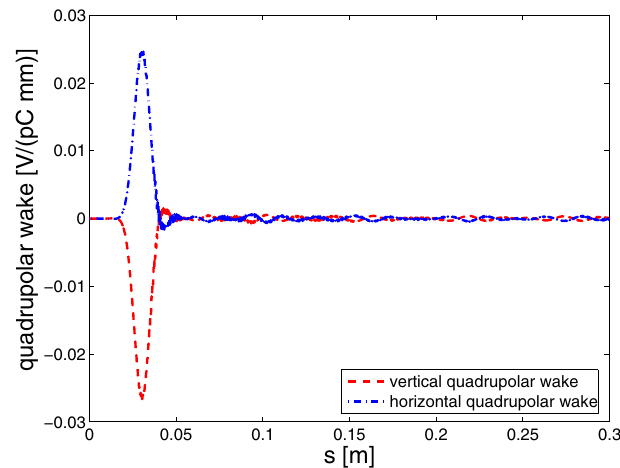
FIG. 9. (Color) The quadrupolar component of the vertical wake (red) and horizontal wake (blue).